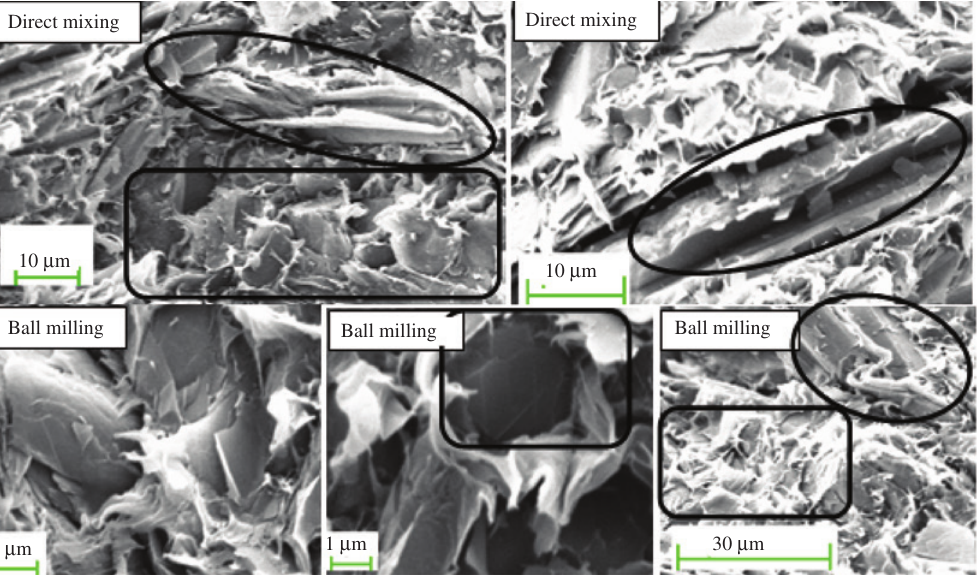
Figure 11: The SEM fracture micrographs of the direct-mixed and ball-milled PP/SG/10 wt.% xGnP composites at different